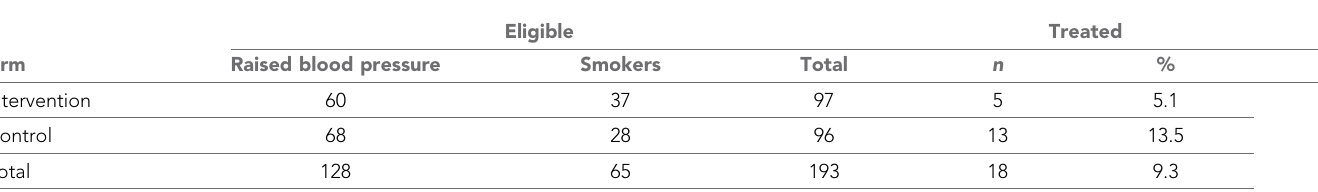
Table 2. Preventive medication Arm